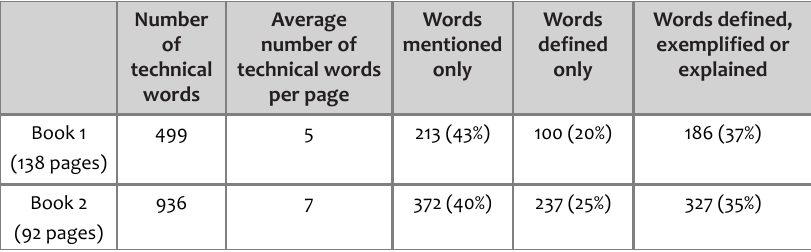
Table 1: Findings from analysis of technical